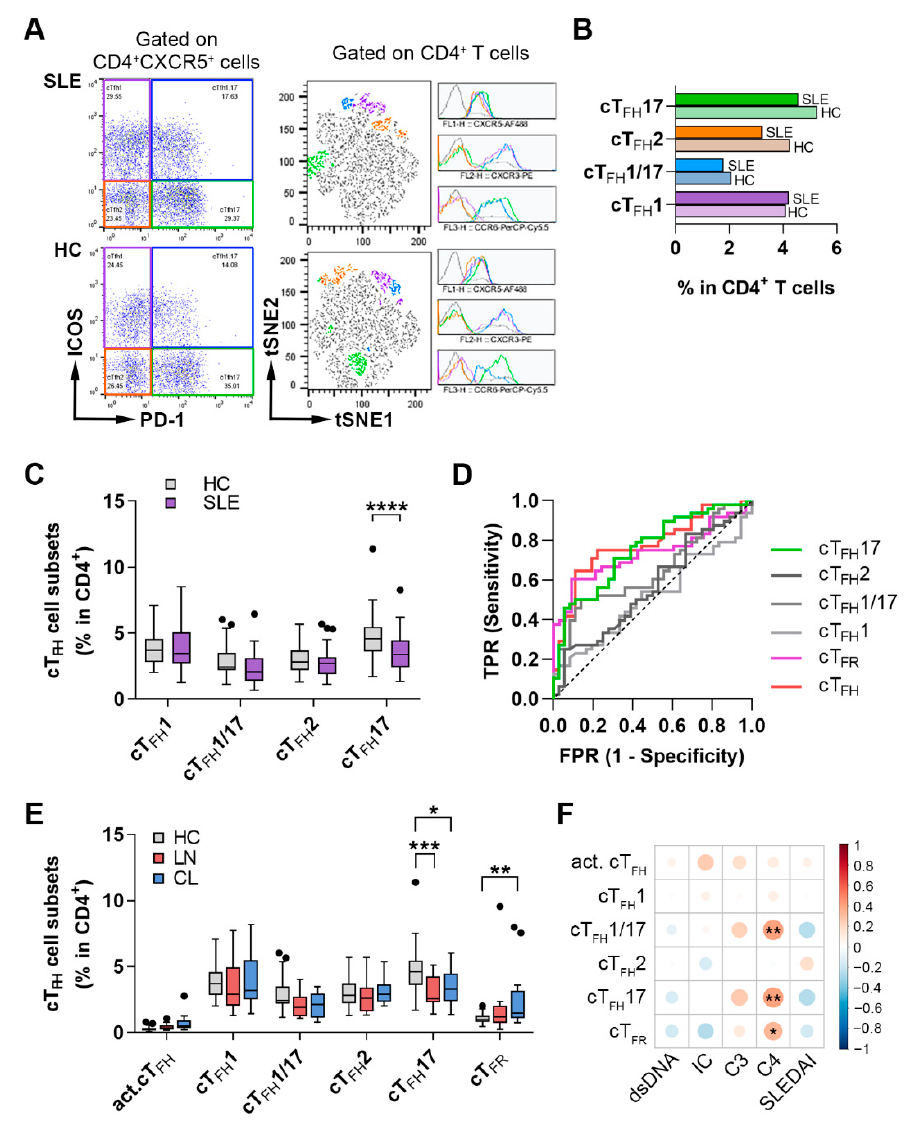
Figure 2. The imbalance of cT FH subsets in SLE patients and their association with disease